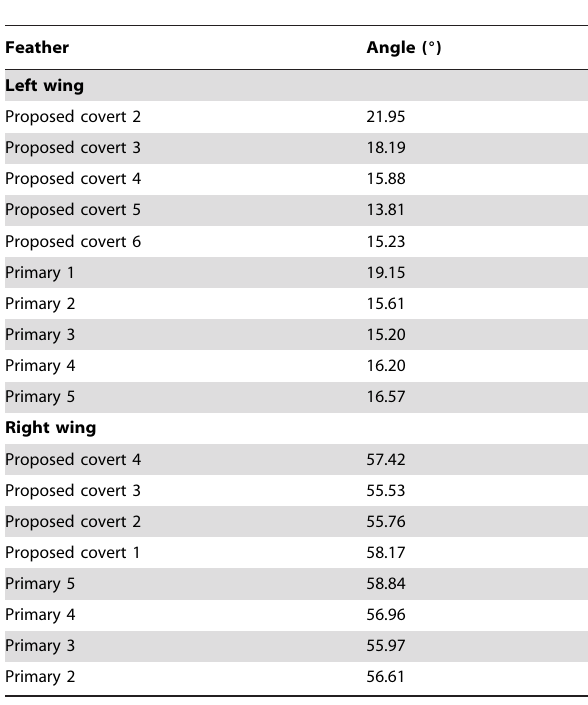
Proposed coverts and primary feathers are numbered from left to right and bottom to top in figures 1D and 2D of Longrich et al . [10] respectively. The angles are calculated relative to the vertical axis in the figures.